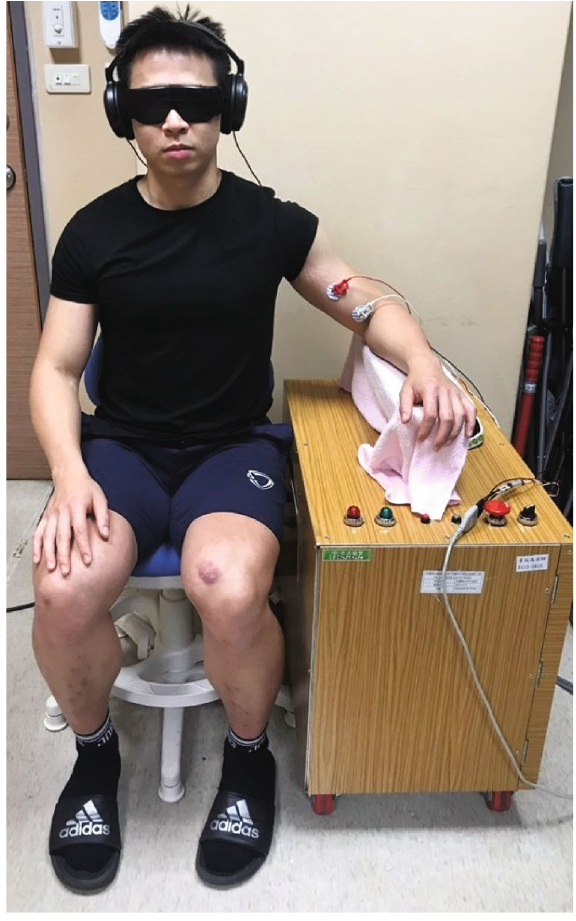
Figure 1: Experimental setup for the passive motion sense